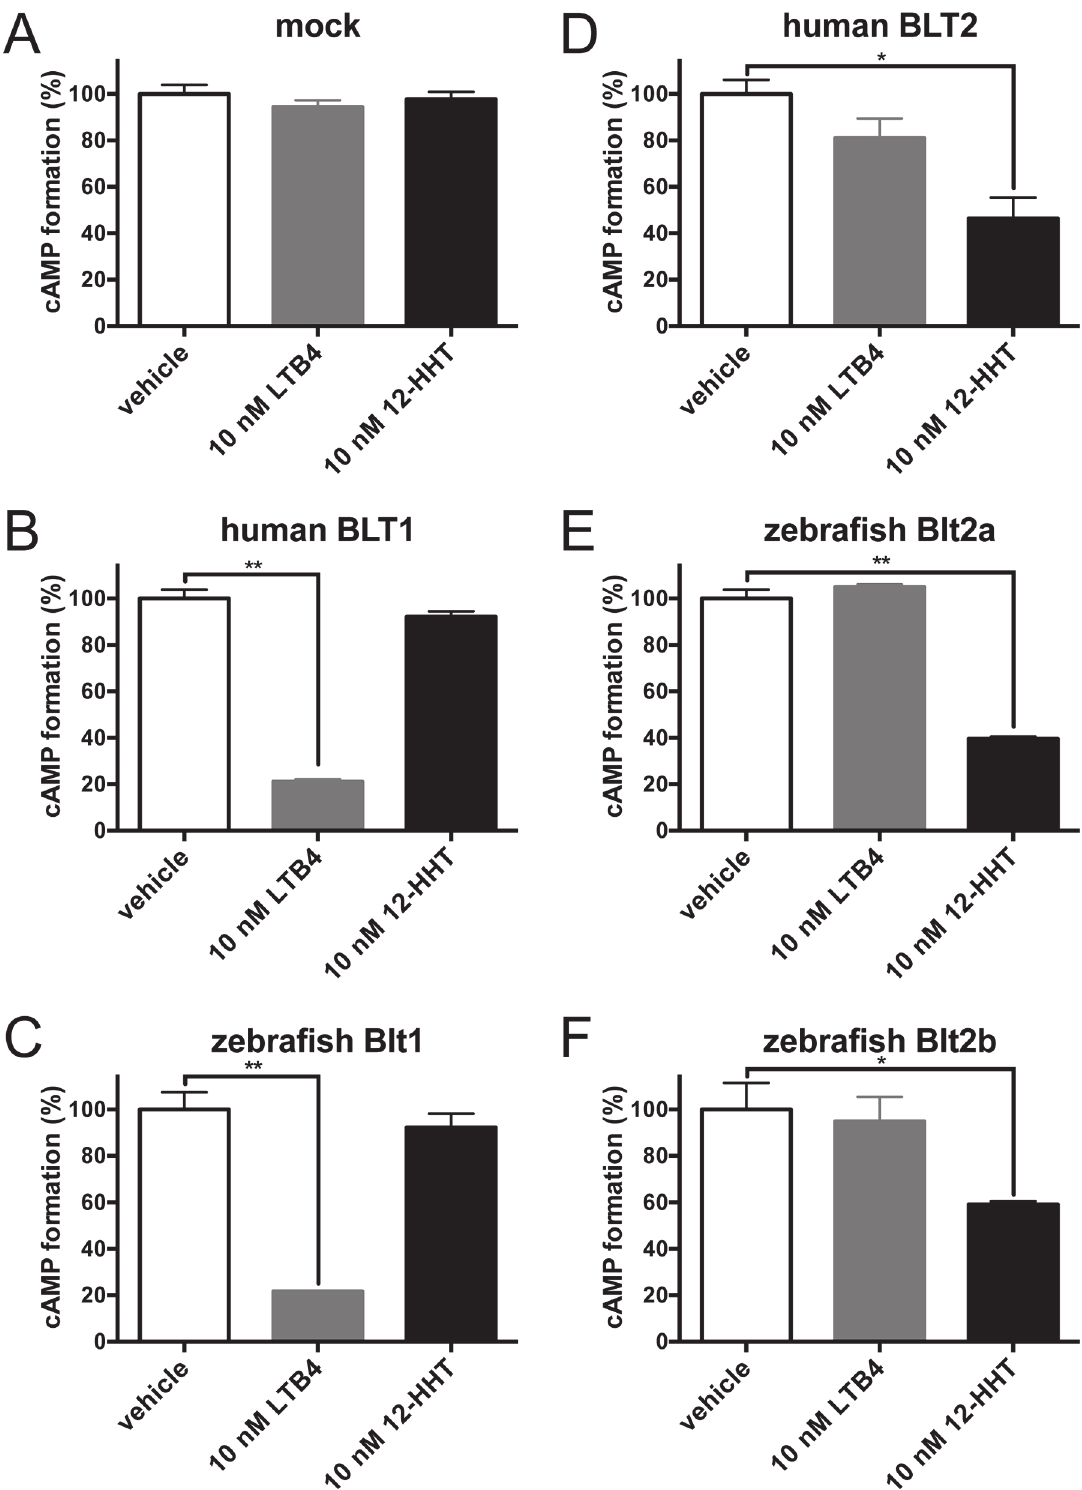
Fig 6. Levels of cAMP in CHO cells expressing the zebrafish Blt receptors. CHO cells stably expressing the human or zebrafish receptors were stimulated with 20 μ M forskolin and 10 nM LTB 4 or 12-HHT, and the levels of cAMP in cell lysates were determined. Data represent the mean ± s.e.m. (n = 3). ** , P < 0.005; * , P < 0.05, one-way ANOVA with Bonferroni post-hoc test. These data are representative of at least two independent experiments with similar results.